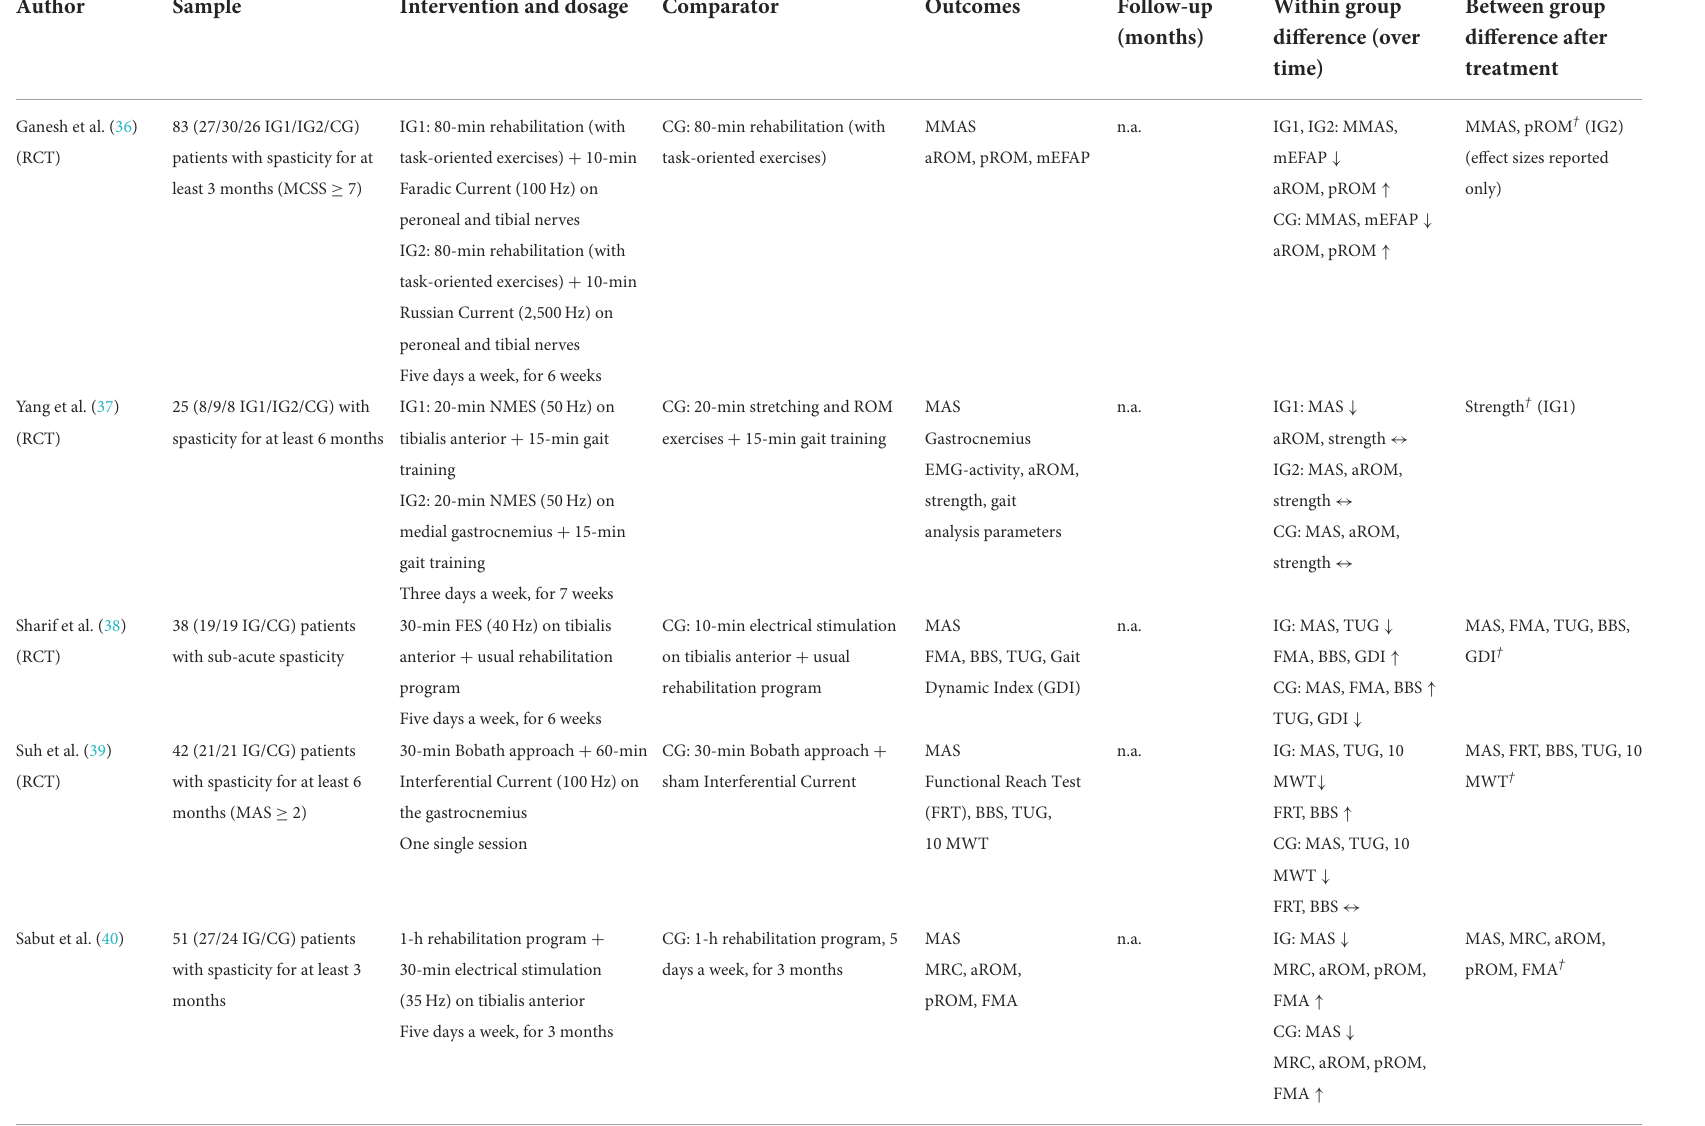
TABLE 3 Characteristics of studies using electrical stimulation for the treatment of triceps spasticity after